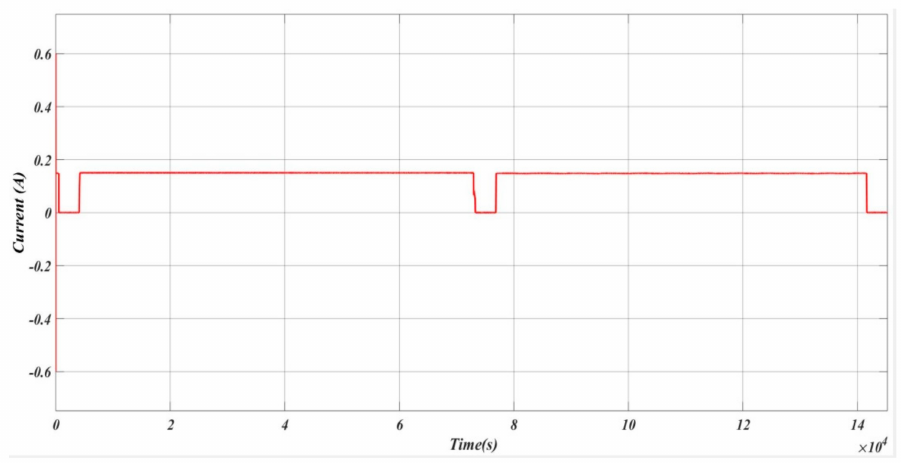
Figure 8. The pattern of the discharging current applied to the